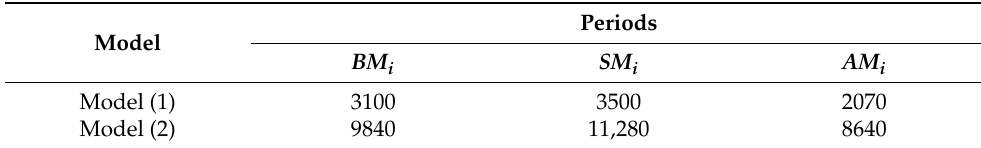
Table 15. Comparison of the number of customers waiting for the three periods with Model (1) and Model (2).